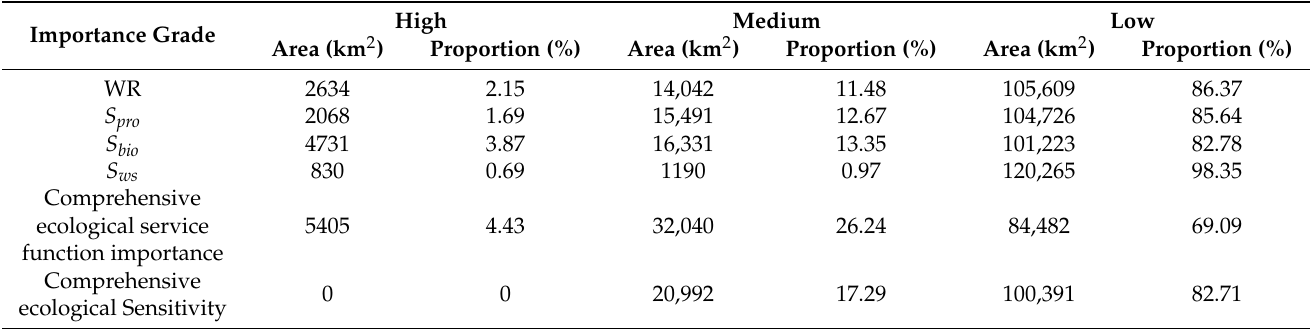
Table 2. The statistics of the ecological service function importance and ecological sensitivity in Fujian.